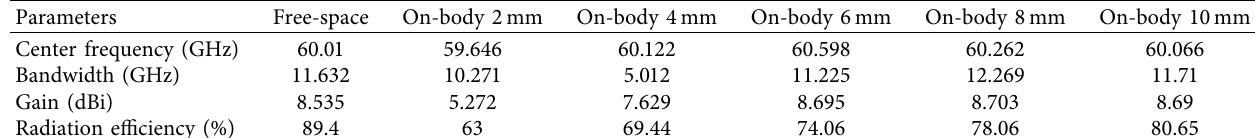
Table 9: 100% polyester on-body performance